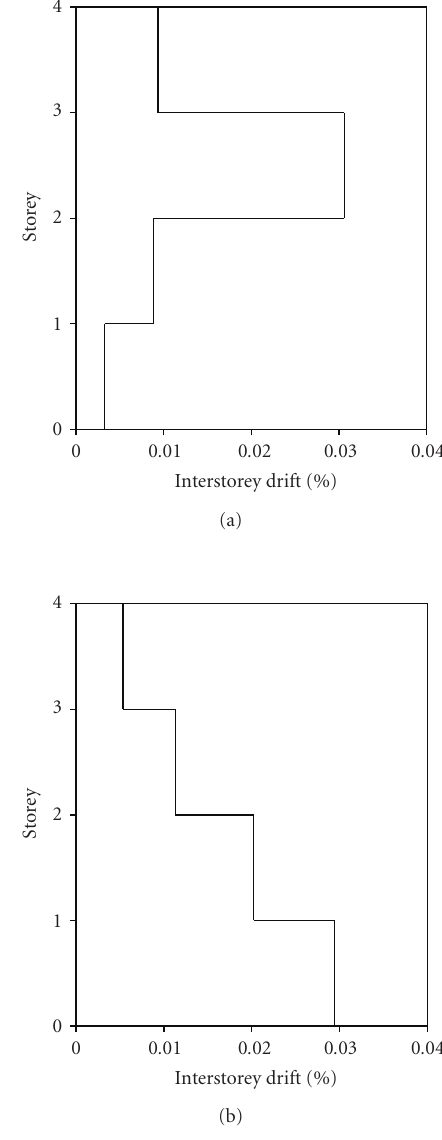
Figure 4: Post-yield interstorey drift profiles in x direction of the building in Figure 3 (a) nonseismically designed (b) c =